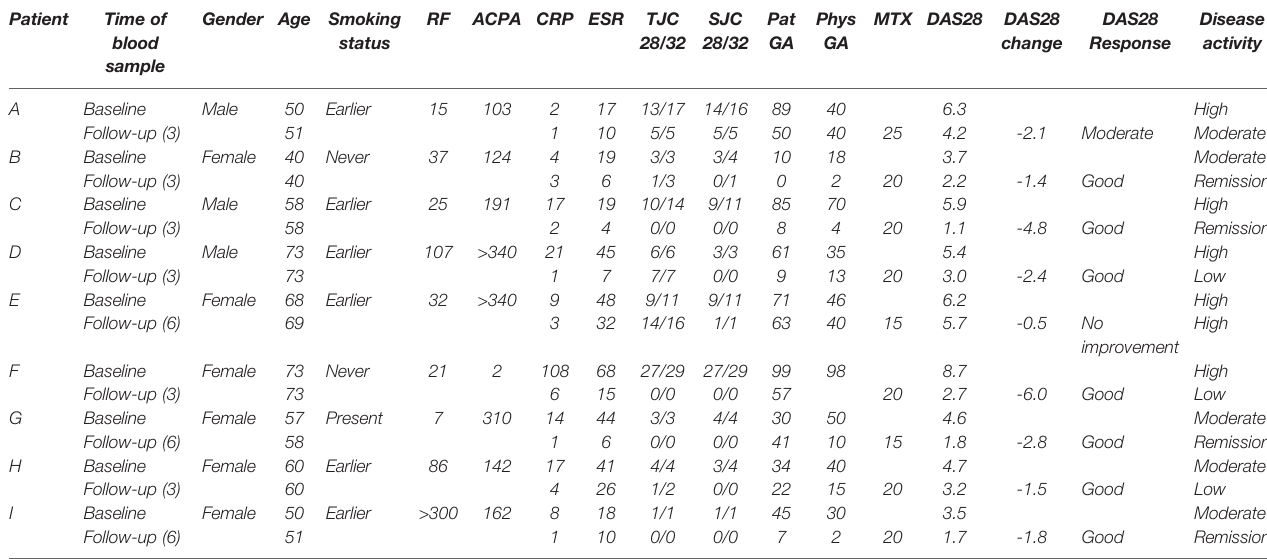
TABLE 1 | Patient characteristics at baseline and follow-up